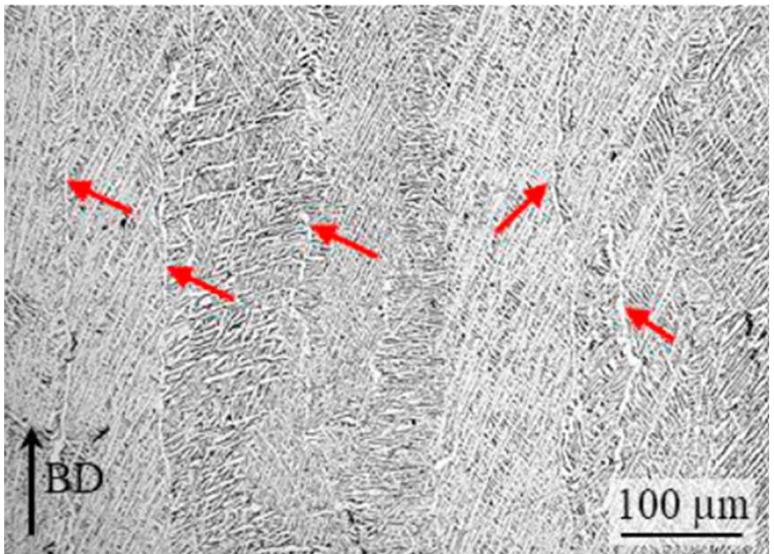
Figure 3. Microstructure along the build-up direction of the PBF-LB Ti-6Al-4V. The red arrows show the α-phase layers along the prior β grains boundaries [103] (Reprinted with permission from [103]. Copyright 2020, Elsevier).